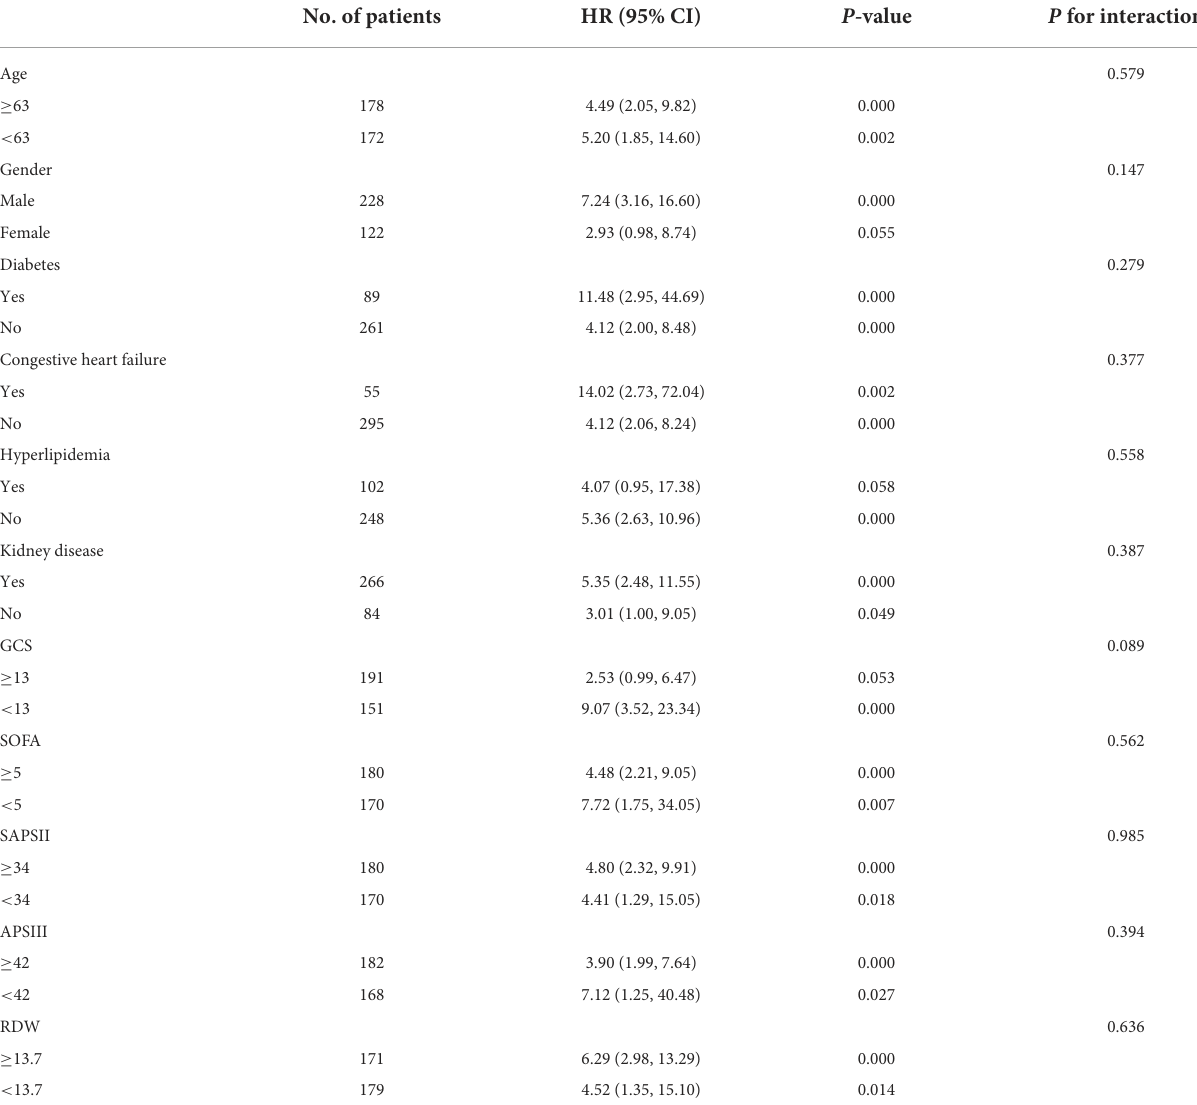
TABLE 4 Subgroup analysis of the associations between 30-day all-cause mortality and the SIRI. No. of patients HR (95% CI) P -value P for